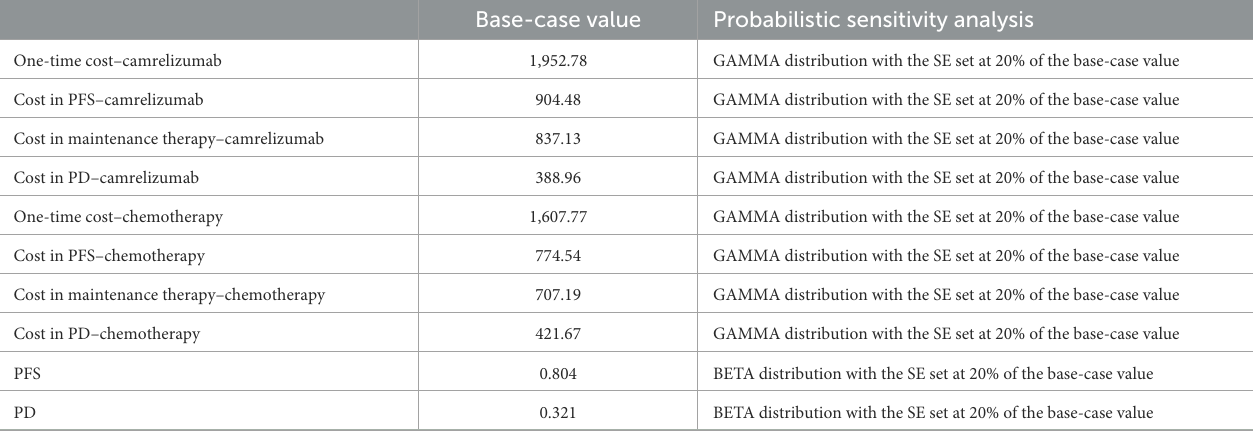
TABLE 3 Sensitivity analysis parameters.